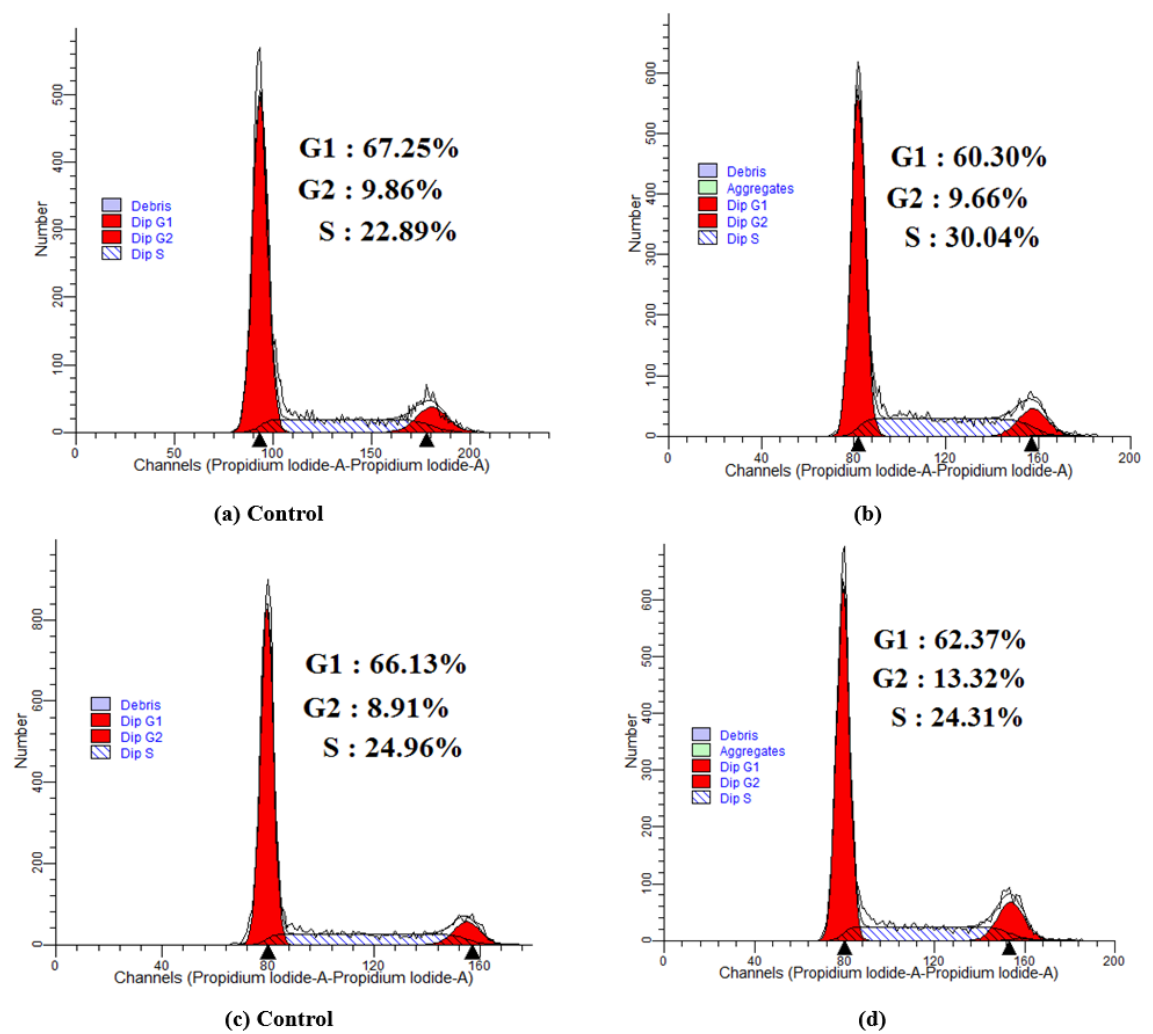
Figure 8. Cell cycle analysis of compound 4h treated T24 cells ( b ) and compound 5d treated MGC80- 3 cells ( d ) at their IC 50 concentrations (8.05 μM and 5.52 μM) for 48 h. And the T24 and